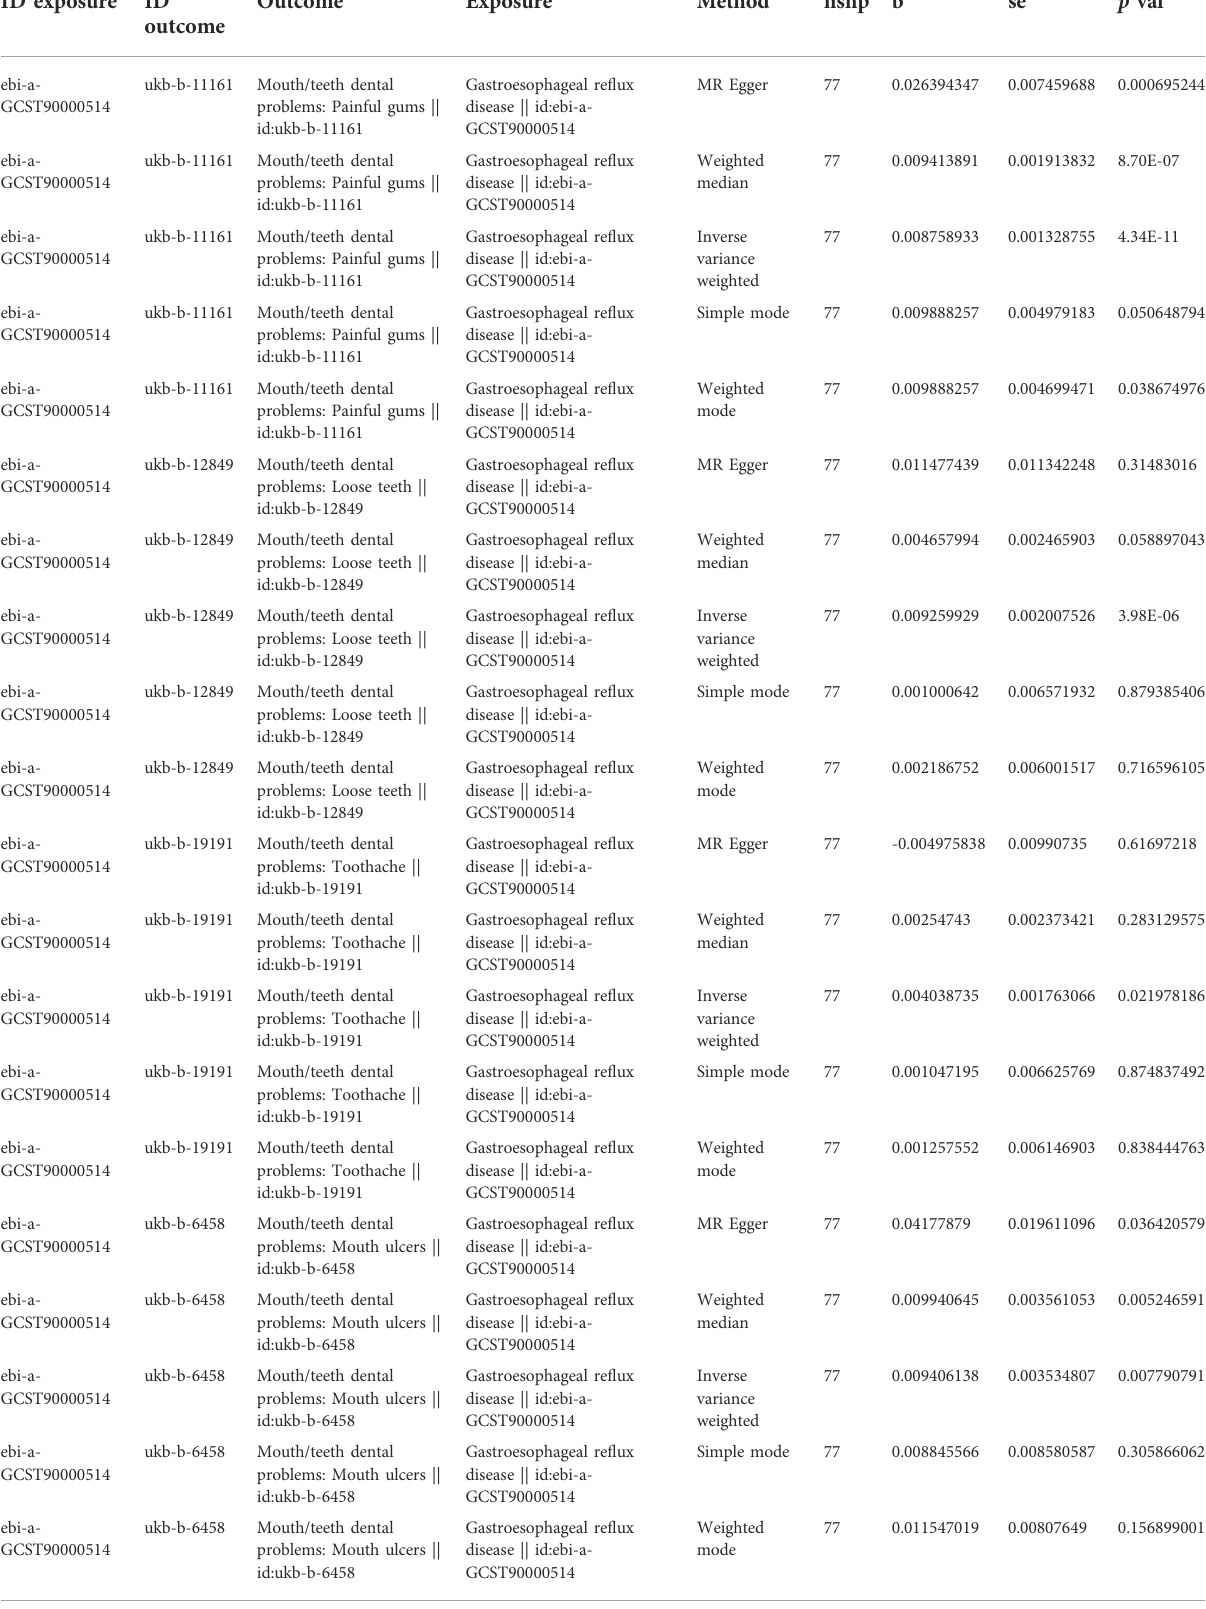
TABLE 2 MR analysis results of fi ve common methods of GERD to painful gums, loosen teeth, toothache and mouth ulcers. ID